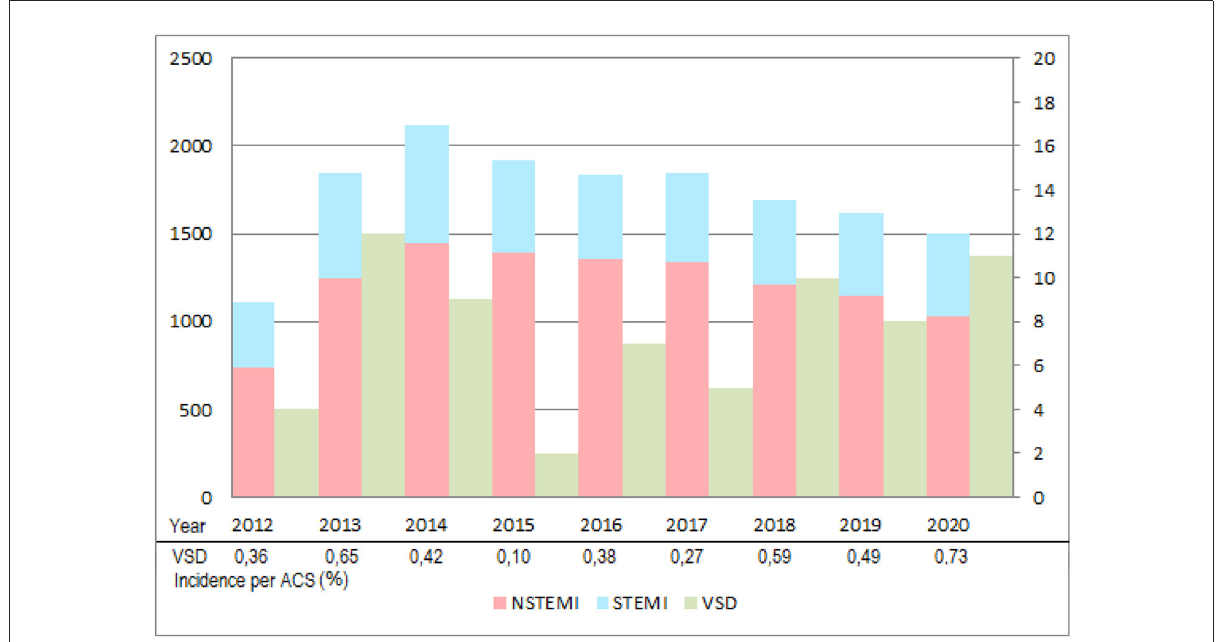
FIGURE1 Annual numerical comparison of acute coronary syndromes (Non-STEMI and STEMI) and ischemic VSD managed between June 2012 and December 2020. Number of Non-STEMI (red) and STEMI (blue) per year are reported on the left axis although VSD (green) is reported on the right. Patients before January 2012 were nor reported since an old data system did not permit a systematic counting of all consecutive cases. ACS, acute coronary syndrome; NSTEMI, non-ST-elevated myocardial infarction; STEMI, ST-elevated myocardial infarction; VSD, ventricular septal defect.